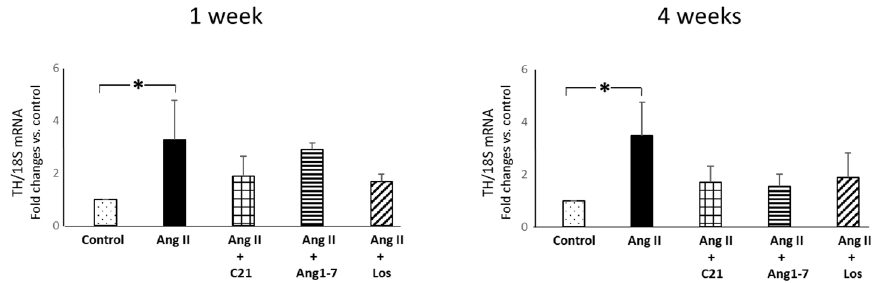
Figure 6. Myocardial mRNA tyrosine hydroxylase expression. Effects of C21 and Ang 1-7 admin- istration on myocardial mRNA tyrosine hydroxylase expression in Ang II treated rats for 1 and 4 weeks. Data are mean ± SEM. *: p <